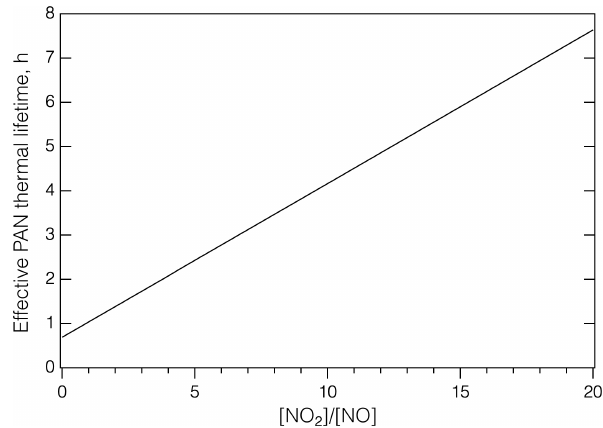
Figure 1. The effective PAN thermal lifetime at 298K as a function of [NO 2 ] / [NO] based on Reactions